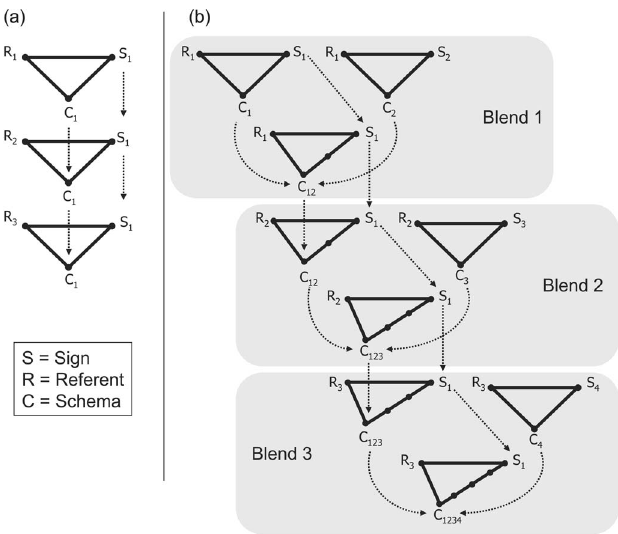
FIG. 10. Two possible diagrams representing layering of mental